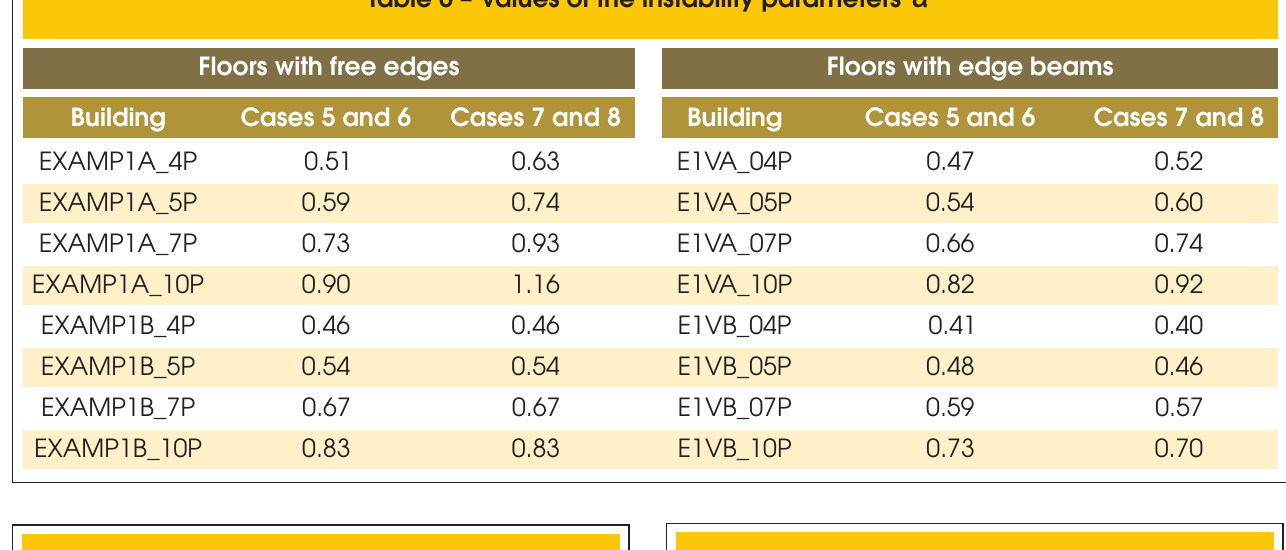
Figure 8 – Instability parameters α